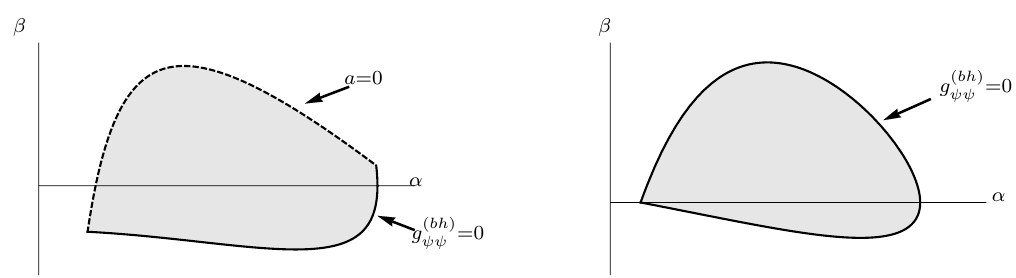
Figure 3 . Region in (cid:11); (cid:12) plane where the twin black hole solution is regular. For x (left (cid:12)gure) the single-center and twin black solutions coexist. For 1 (cid:20) x < x single-center solution violates the CCB but the twin black hole with the same asymptotic charges is